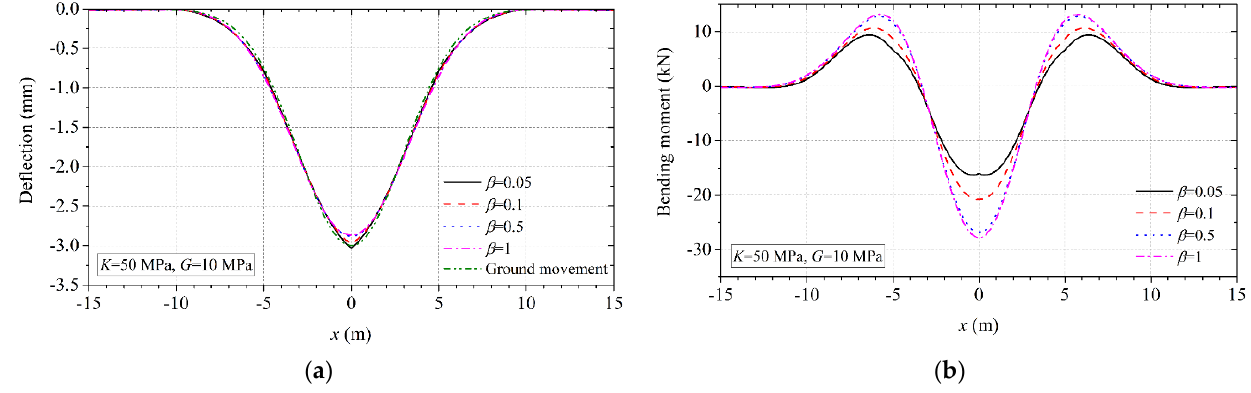
Figure 12. Deflection and bending moment of buried pipeline with different stiffness reduction factors: ( a ) deflection; ( b ) bending moment.